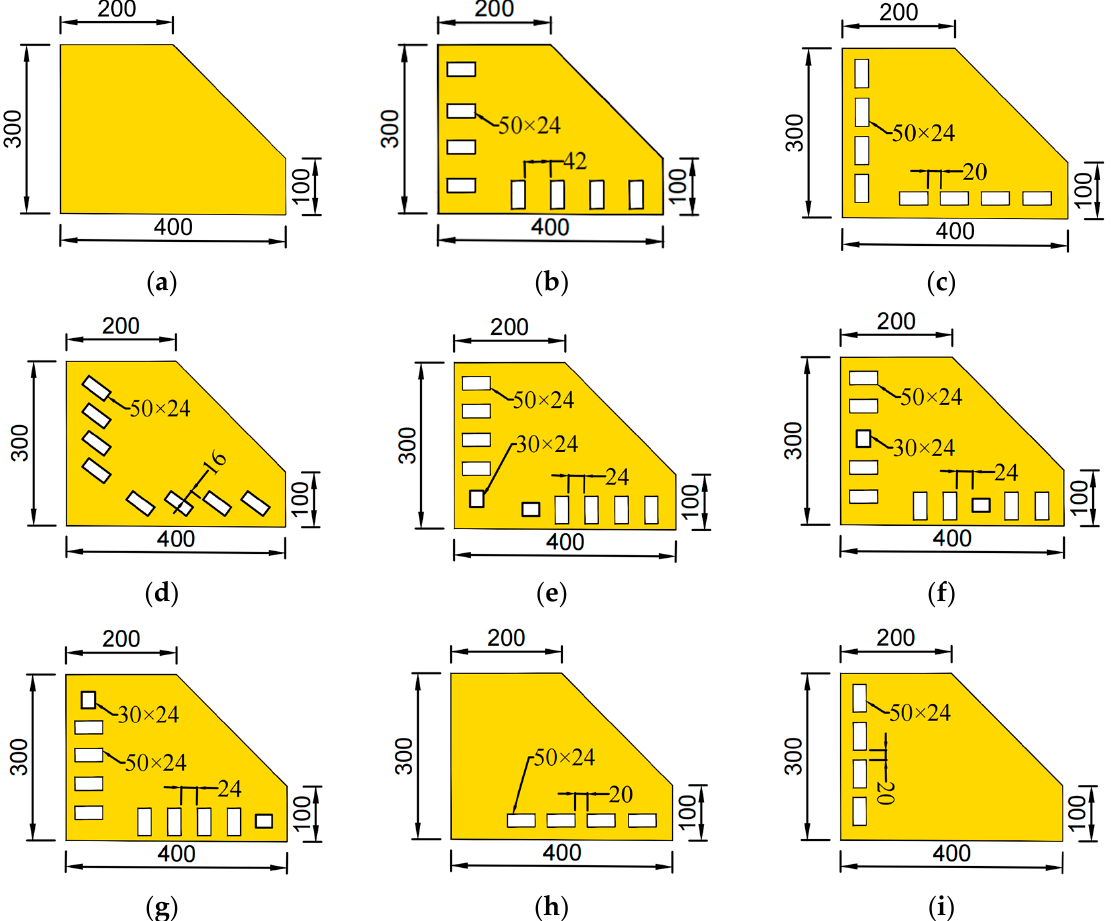
Figure 6. Details of differently slotted gusset plates : ( a ) TG; ( b ) NG-V; ( c ) NG-H; ( d ) NG-S; ( e ) NG- VH-1; ( f ) NG-VH-3; ( g ) NG-VH-5; ( h ) NG-H-B; ( i )